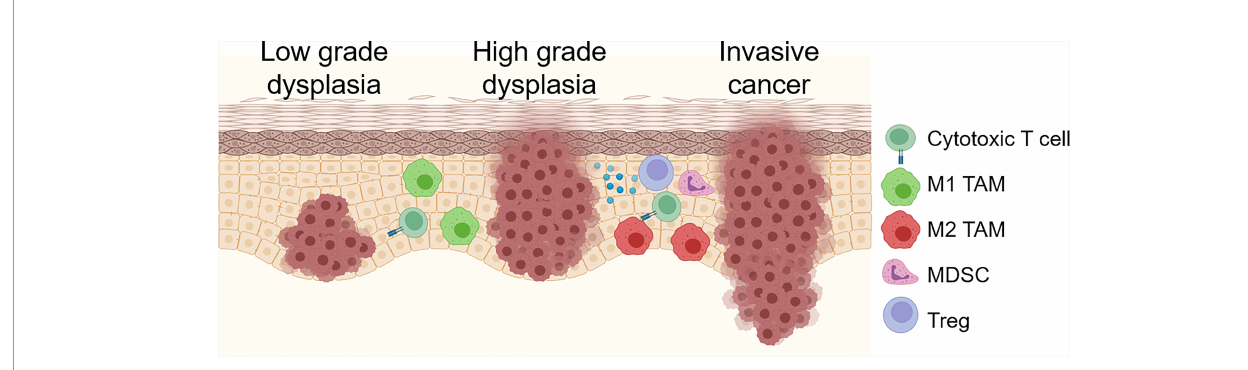
FIGURE 1 | Schema for immune/in fl ammatory microenvironment evolution during OPL progression. OPL are often strongly in fi ltrated with CD8 + T cells. Early low grade dysplasias also demonstrate tumoricidal and/or M1 TAMs. As dysplastic lesions progress, increased immunosuppressive M2 TAM, Treg, MDSCs and immunosuppressive molecules including PD-1/PD-L1 and A2AR. Created with